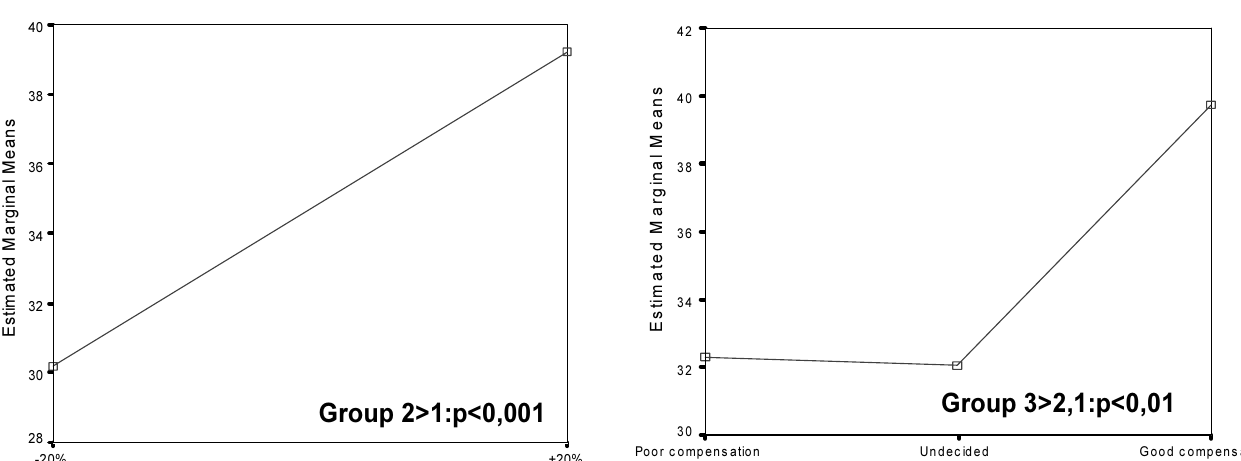
Group 3>2,1:p<0,01 Group 2>1:p<0,001 Figure 3: Lay-off magnitude Figure 4: Severance compensation